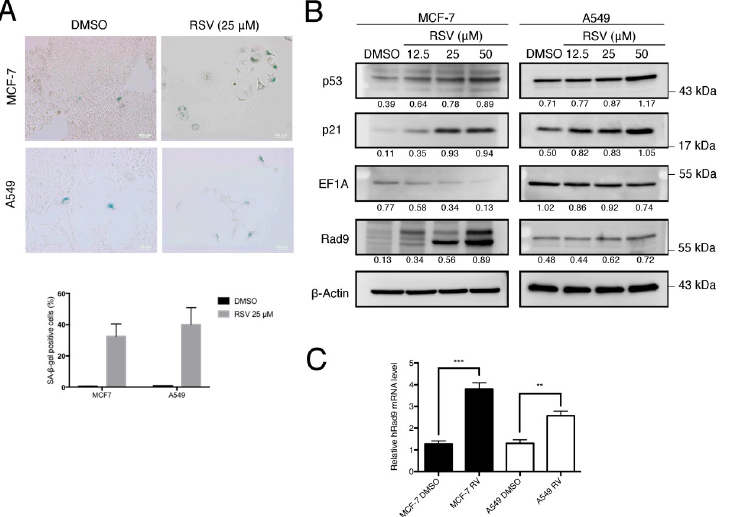
Fig 2. Rad9 involved RSV induction of premature senescence in MCF-7 and A549 cell lines. (A) SA- β -gal assays were performed 7 days after treated with 25 μ M of RSV in MCF-7 and A549 cell lines. Scale bar, 100 μ m, representative of three independent experiments. (B) Western blotting was performed to determine the expression of p53, p21, Rad9, and EF1A in RSV treated MCF-7 and A549 cells. β -Actin was used as a loading control. (C) Real-time PCR was performed to determine Rad9 gene expression in RSV treated cells. Data are means ± s.d., �� , ���� P � 0.05 (control vs. each treatment), representative of three independent experiments. Signals on the western blots were analyzed by ImageJ, normalized with that of β